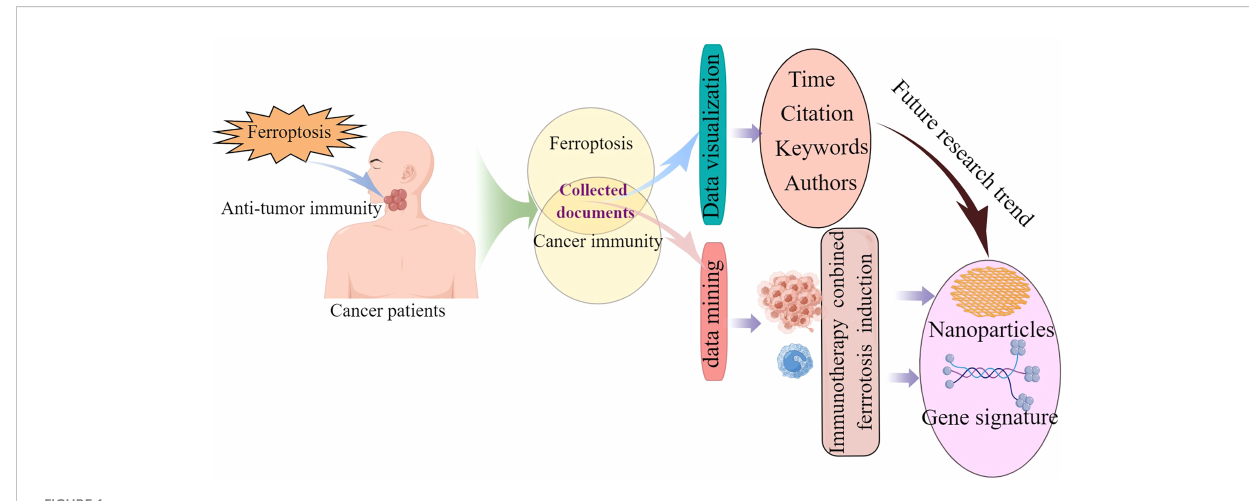
FIGURE 1 The graphic abstract of this research. The detailed description is in